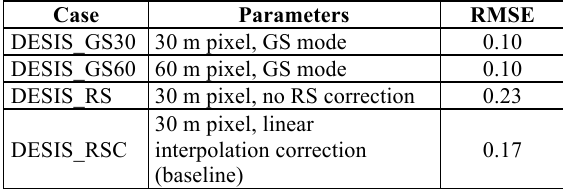
Table 4. Error (RMSE) on abundances estimation for the different simulated